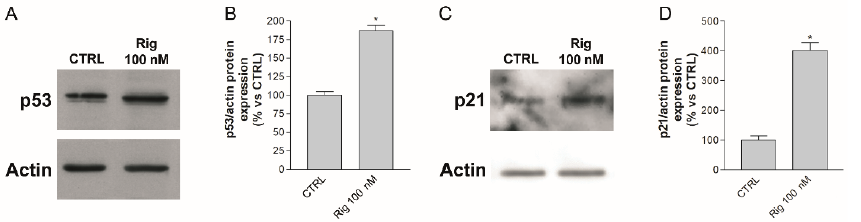
Figure 6. p53 and p21 expression in EGI-1 cells treated with Rig. ( A ) Representative image of p53 and actin Western blot after 24 h of treatment with Rig 100 nM. ( B ) The graph represents the quantification of p53 Western blot and data are represented as the mean percentage ± SD of p53 normalized to actin of three independent experiments, compared to untreated controls arbitrarily set to 100%. ( C ) Representative image of p21 and actin Western blot after 24 h of treatment with Rig 100 nM. ( D ) The graph represents the quantification of p21 Western blot and data are represented as the mean percentage ± SD of p21 normalized to actin of three independent experiments, compared to untreated controls arbitrarily set to 100%. * p < 0.05 vs. CTRL.